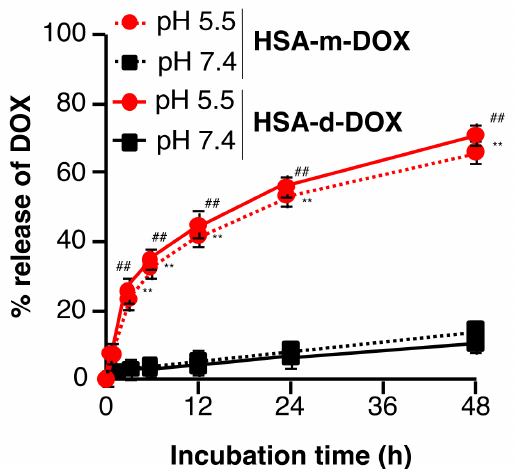
Figure 2. In vitro pH-dependent DOX release profile of HSA-m-DOX or HSA-d-DOX. HSA-m-DOX or HSA-d-DOX was diluted with PBS (pH 7.4) or acetate buffer (pH 5.5) to 2.0 mg (DOX)/mL. After incubation, the fluorescence intensity (Ex/Em: 488 nm/585 nm) was measured. Data are averages ± standard deviation ( n = 4). ** p < 0.01 vs. HSA-m-DOX in pH 7.4 group. ## p < 0.01 vs. HSA-d-DOX in pH 7.4 group.